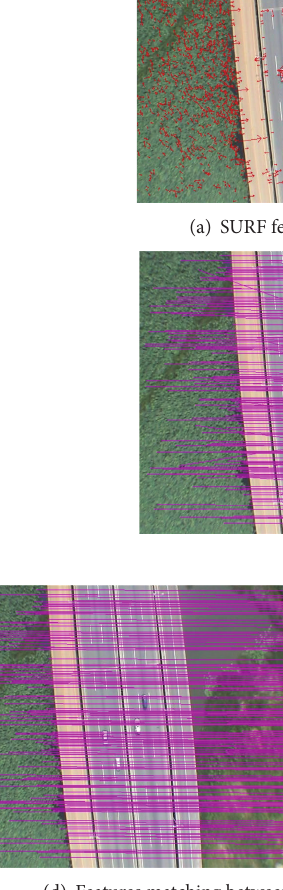
Figure 4: Image registration with SURF key points and image